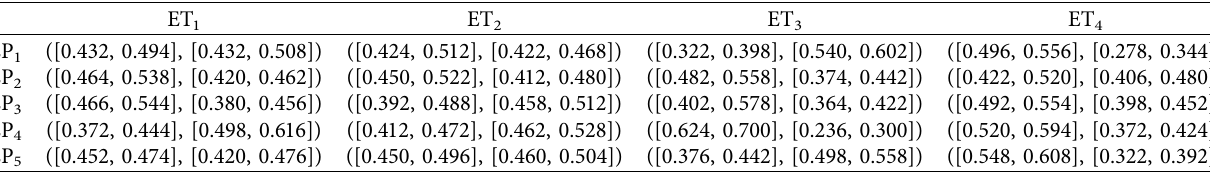
Table 8: The weights ta